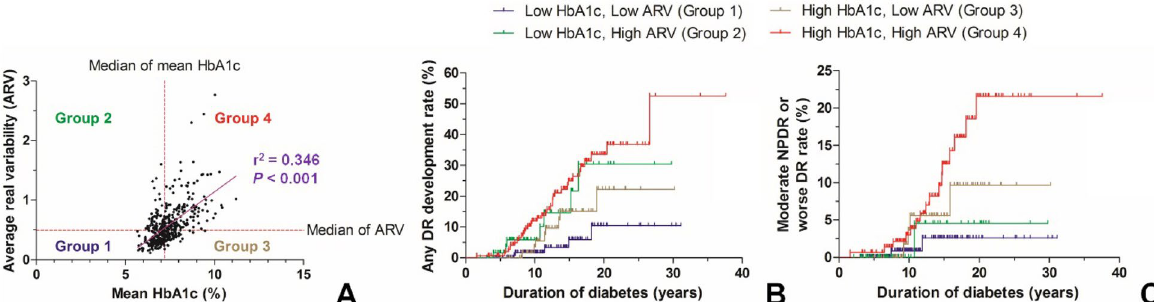
Figure 2. Comparison of development and progression rate of diabetic retinopathy (DR) according to the mean and average real variability (ARV) of HbA1c level. ( A ) Subject grouping according to their mean and ARV value of HbA1c. The mean and ARV of HbA1c showed a significant positive correlation (r = 0.588, p < 0.001). ( B , C ) Comparison of the rate of the DR development ( B ) and DR progression to moderate nonproliferative DR or worse DR ( C ) in four